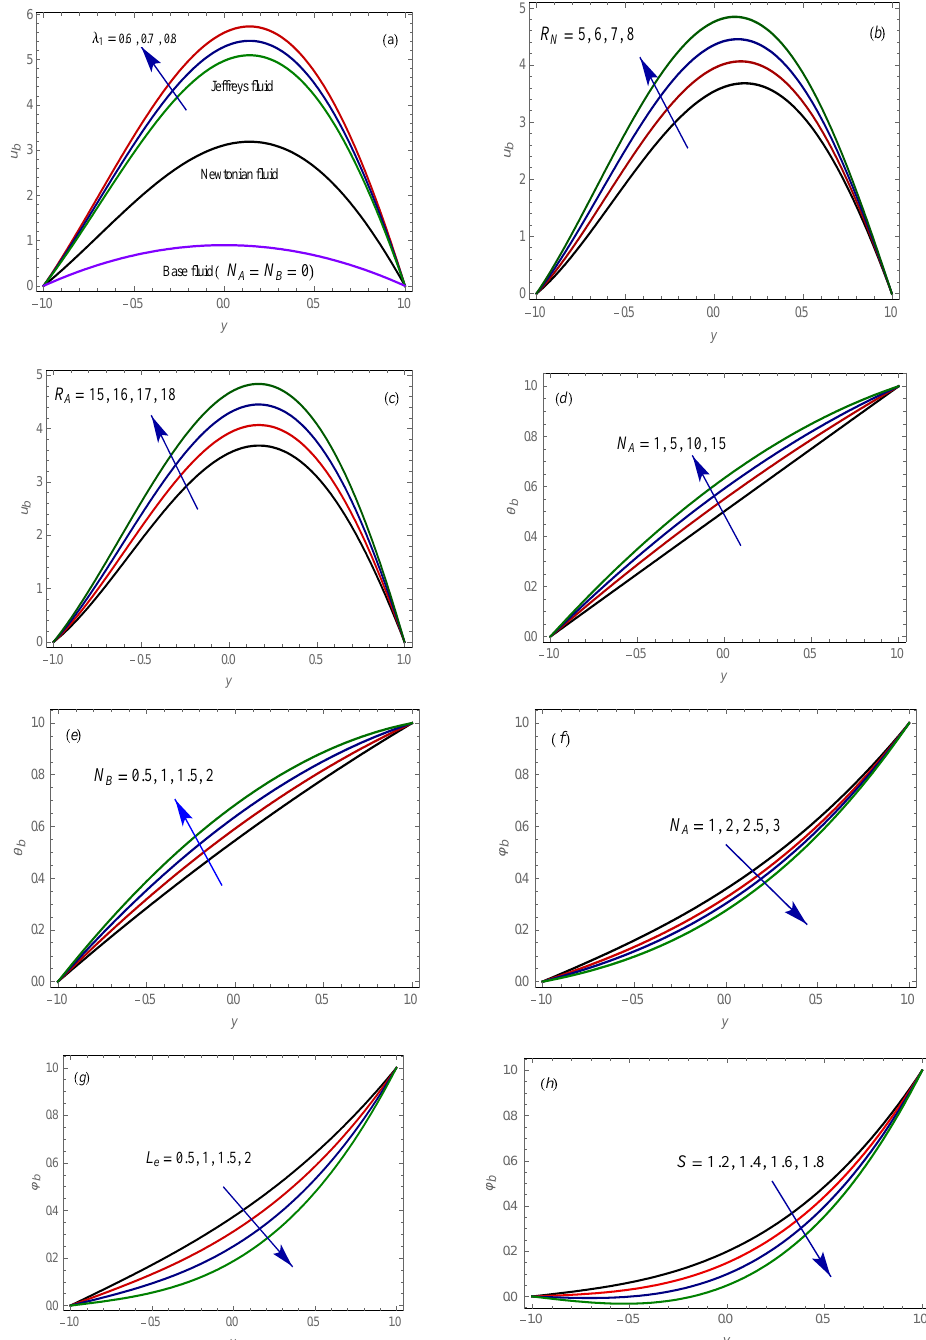
Figure 2. Plots of basic state curves for different values of 𝜆 1 , 𝑅 𝑁 , 𝑅 𝐴 , 𝑁 𝐴 ,𝑁 𝐵 ,𝐿 𝑒 𝑎𝑛𝑑 𝑆 𝑤𝑖𝑡ℎ 𝑃 𝑟 = 1 𝑎𝑛𝑑 𝑅 𝑛 = .5, ( a – c ) Velocity, ( d , e ) temperature and ( f – h ) nanoparticles fixation profiles of the basic state for different values of governing parameters. These results are obtained by analytical solutions